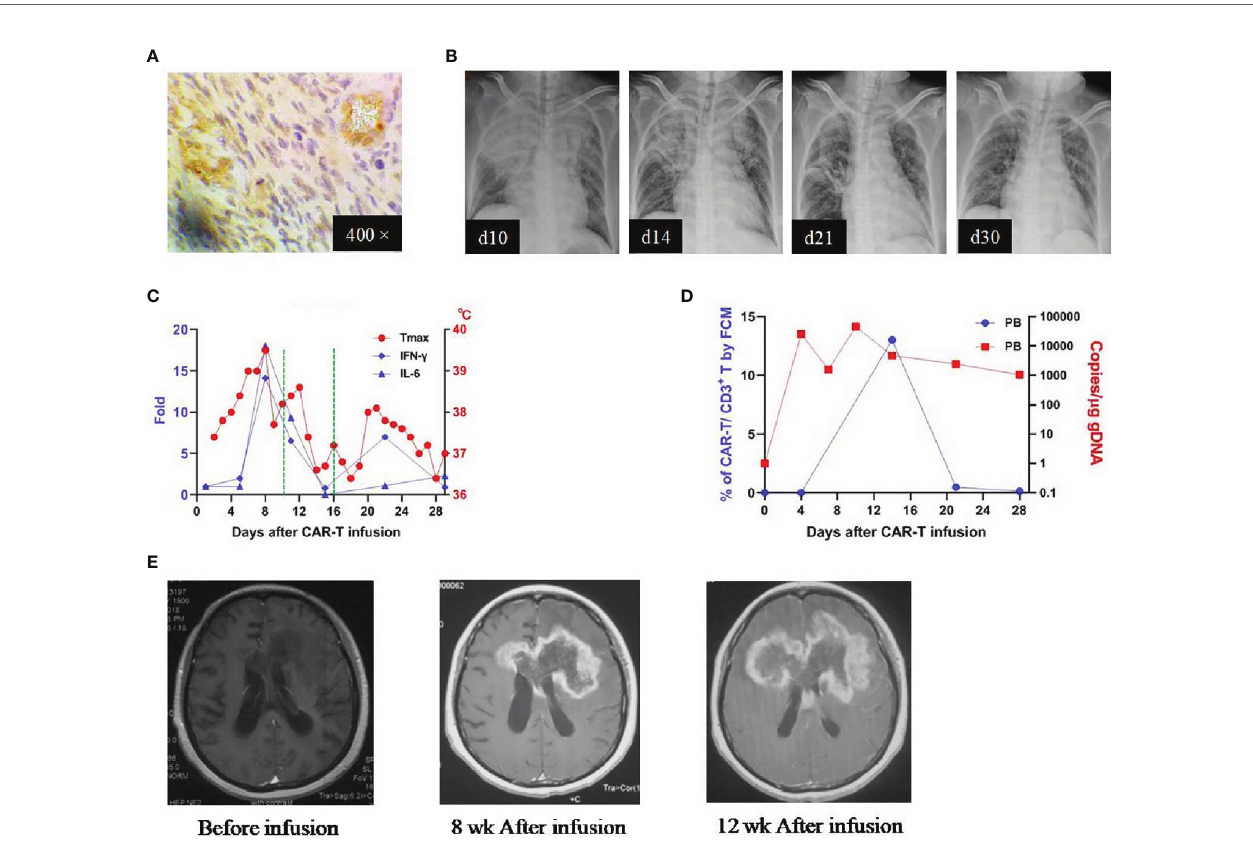
FIGURE 2 | IHC staining of the tumor and clinical response in patient 1. (A) Anti-EphA2 IHC staining of tumor tissue before enrollment. (B) Thoracic X-ray performed on days 10, 14, 21, after the infusion of CAR T-cells, showing the development and resolution of pulmonary edema in the right superior and middle lobes. (C) Dynamic changes of critical cytokines in the peripheral blood along with temperature, after the infusion of CAR T-cells. The dotted green line on the x-axis indicating the time window for the use of dexamethasone. (D) Expansion of CAR T-cells in the peripheral blood by fl ow cytometry (left y-axis) and qPCR (right y-axis). (E) Contrast-enhanced MRI performed before and after (8 and 12 weeks) the infusion of CAR